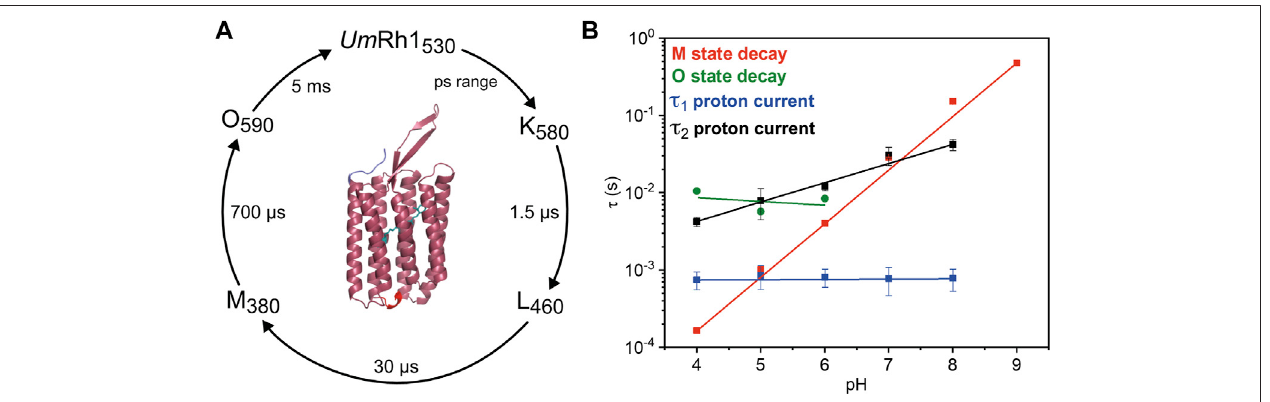
FIGURE 8 | Photocycle of solubilized Um Rh1. (A) The depicted photocycle plot describes the intermediate state transitions of Um Rh1 in 100 mM NaCl, 50 mM sodium acetate,pH 5,0.03% DDM. Thenumbers show the maximal difference absorption wavelength ofeach intermediate state and thecorresponding timeconstant. Inthecenter,ahomologymodelof Um Rh1isshownbyusingthefungalrhodopsinLR(pdb:7bmh)(Zabelskiietal.,2021)astemplate.Theretinal(green)isimportedfrom structure of Acetabularia Rhodopsin I (pdb: 5awz). The N and C termini are indicated with blue and red. (B) pH dependence of the M (red squares) and O state decays(greenspheres)andthekineticsofprotontranslocationasderivedfromelectrophysiology.Datapointsrelatetothetwotimeconstantsofthedecaykineticsofthe proton currents ( τ 1 in blue and τ 2 in black squares, see Table 1 for the values). Straight lines are guides to the